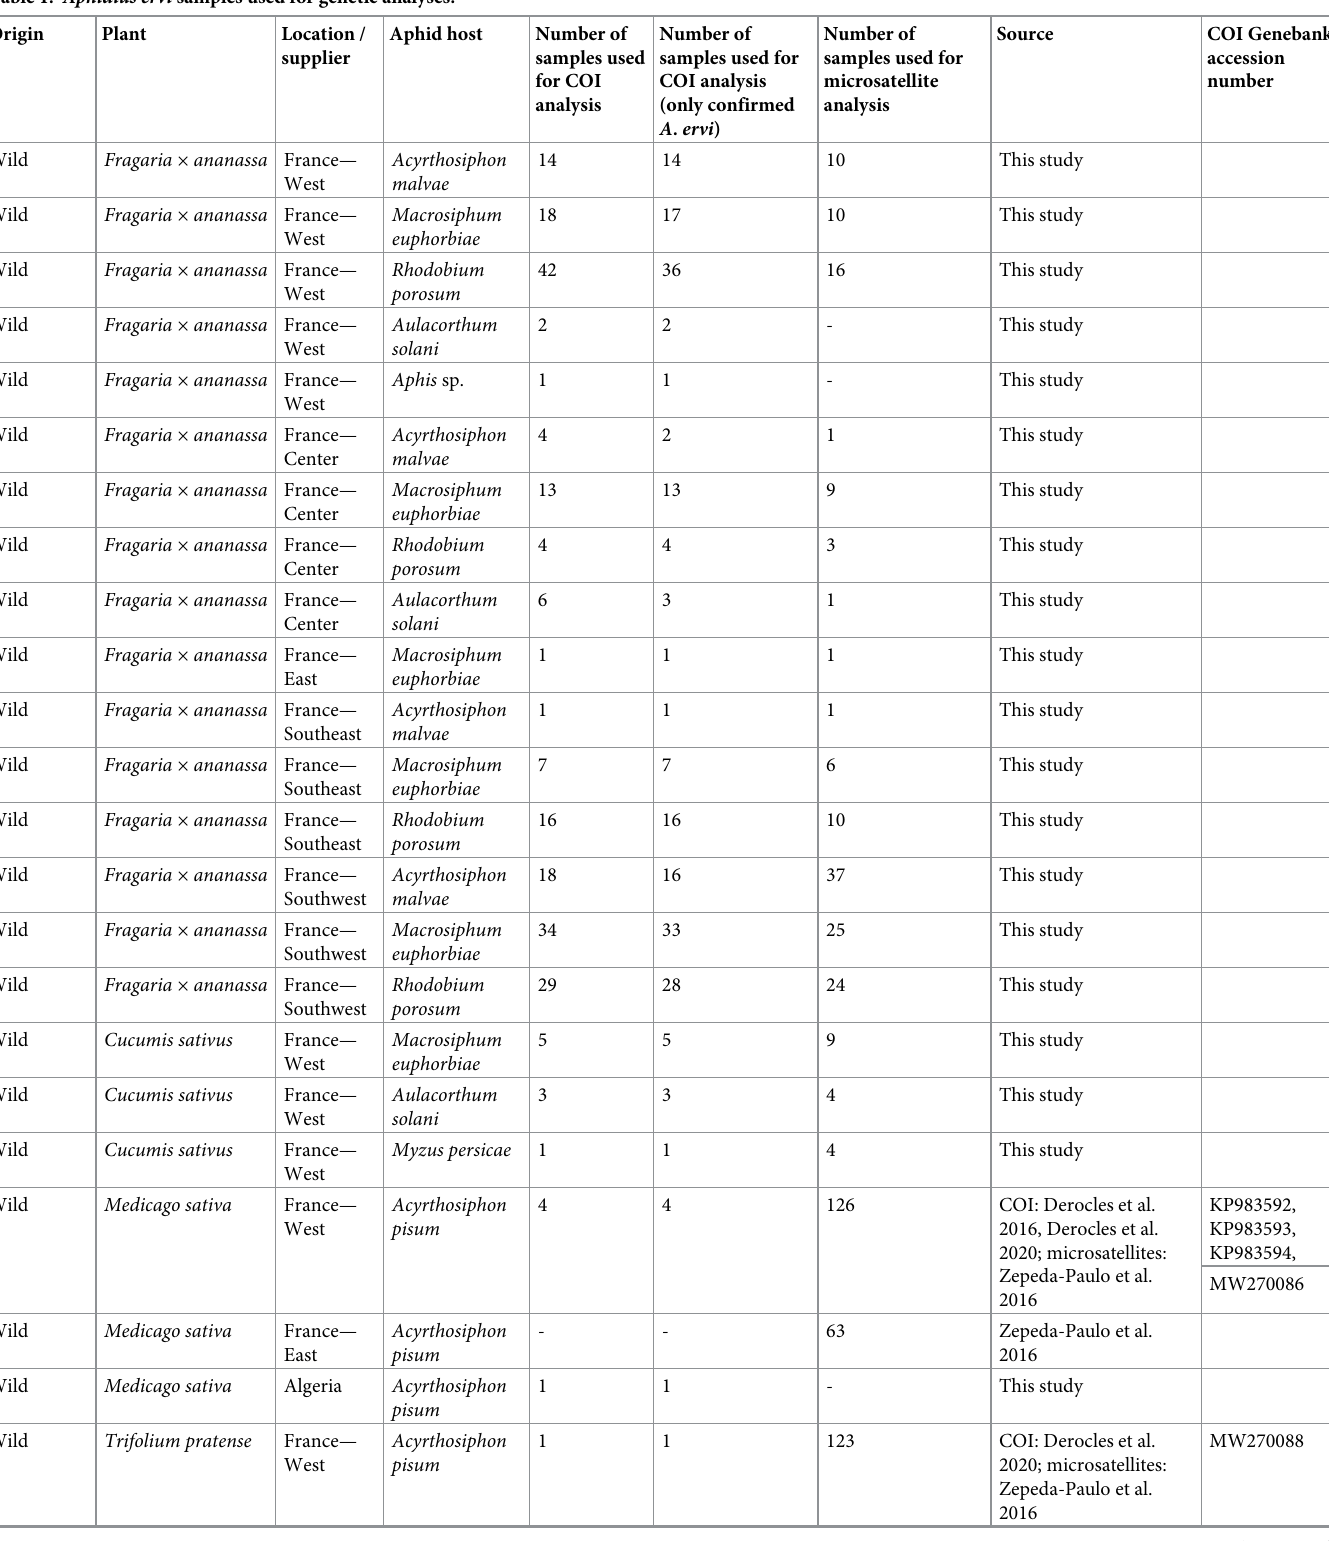
Table 1. Aphidius ervi samples used for genetic